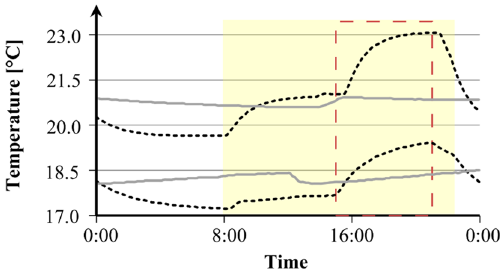
Figure 8. Daily temperature profiles of the control (18 °C; bottom) and high-temperature (21 °C; top) treatments in scenario 1(solid grey lines) and 2 (dotted black lines). In both scenarios, light was provided to experimental animals daily between 8 am and 10 pm (yellow box). All treatments in scenario 2 contained an extra temperature step of + 1.5 °C for six hours daily (between 15:00 and 21:00 h; red